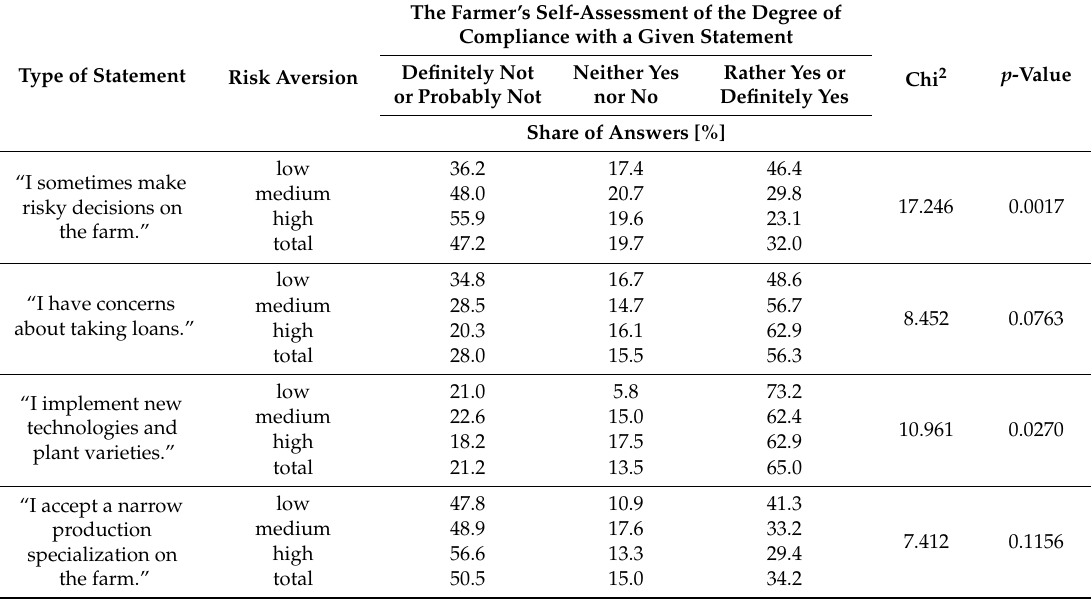
Table 4. Farmer self-assessment concerning deciding their risk